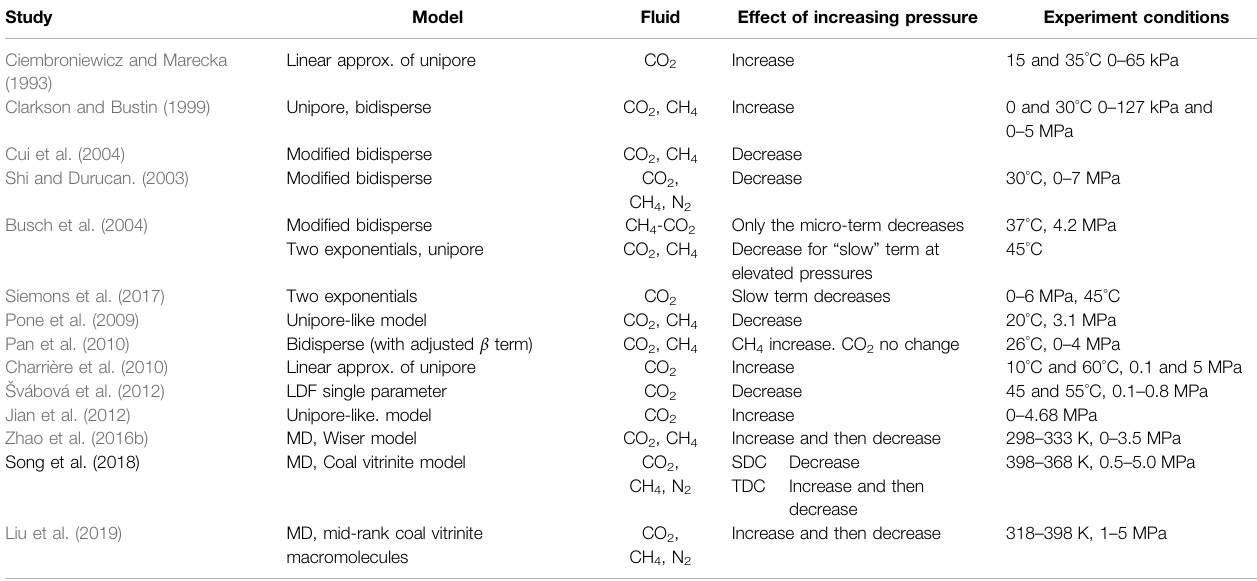
TABLE 3 | Effects of the pressure on the diffusion coef fi cients for various gaseous adsorbates in coal (modi fi ed from Staib et al. (2013)).